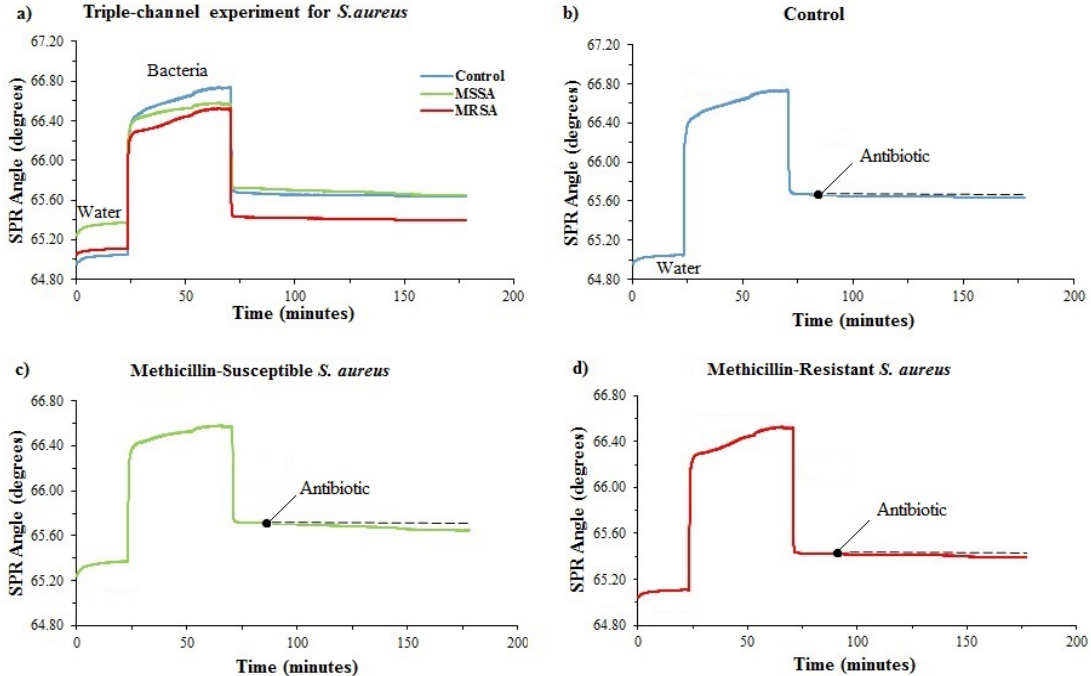
Figure 5. ( a ) Real-time SPR kinetic curve for antibiotic-resistant and susceptible S. aureus against cefoxitin treatment on 3-channel system. ( b ) Control sample, E. coli . ( c ) Methicillin-susceptible S. aureus (the strain of MRSA 2). ( d ) Methicillin-resistant S. aureus (the strain of MRSA 2).